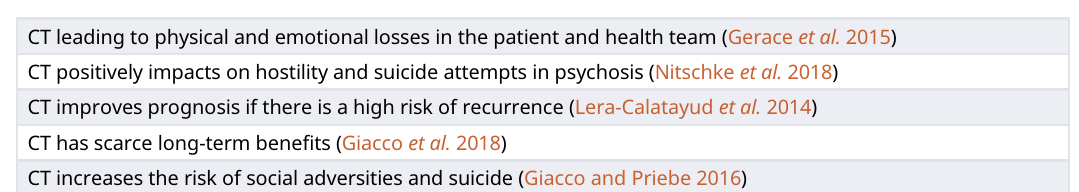
Table 5. Contradicting evidence of compulsive treatment